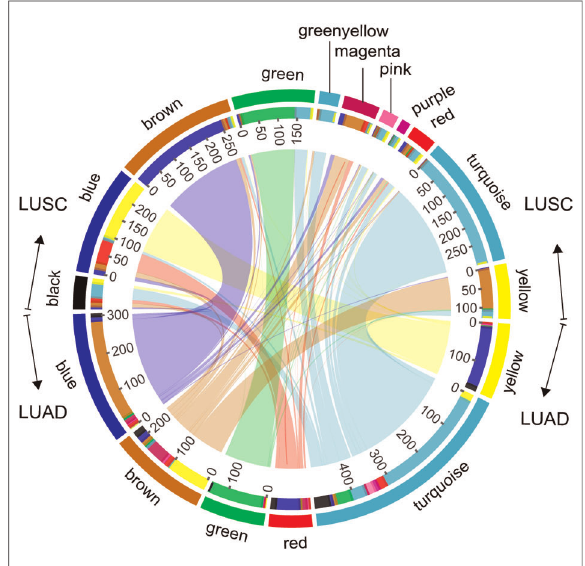
FIGURE 2 Module overlaps. Circles represent, from outermost to innermost, the color labels of modules of LUSC and LUAD, the number of genes, and internetwork